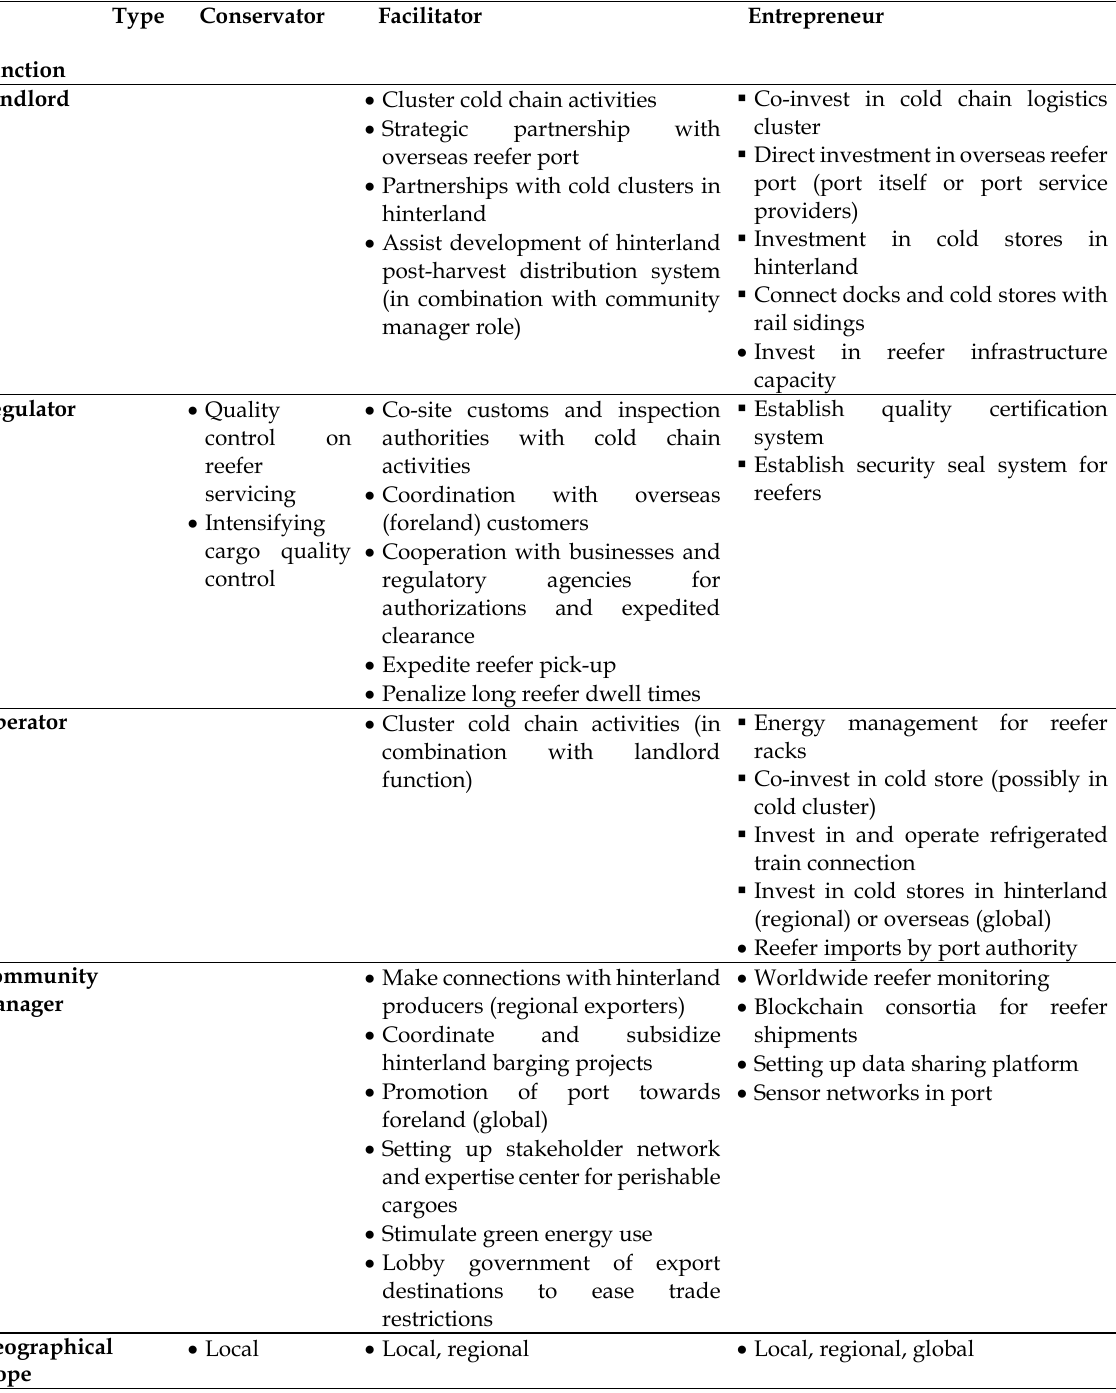
Table 5. Port authority ‘renaissance